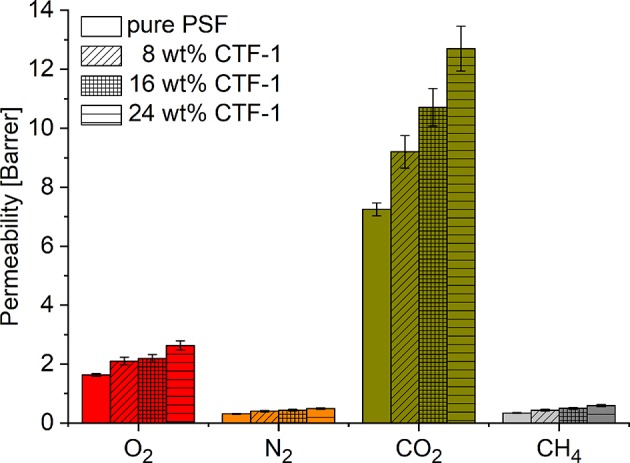
Gas permeability of 0, 8, 16, and 24 wt% of CTF-1@PSF composite MMMs for O2, N2, CO2, and CH4.